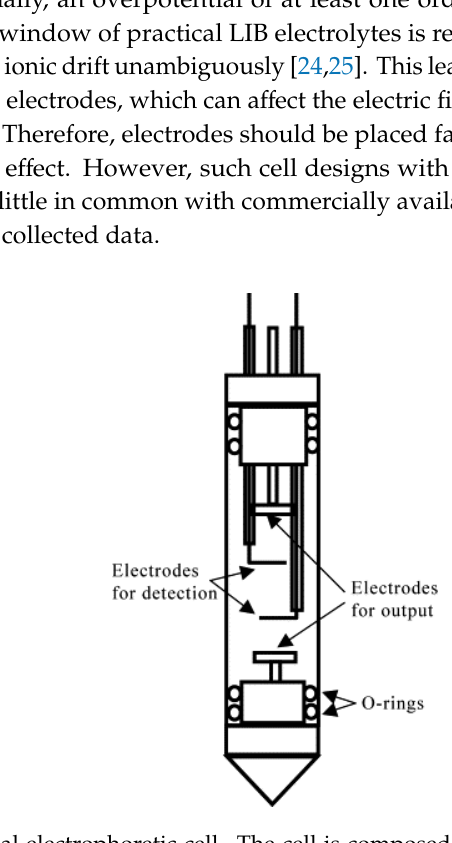
Figure 2. Four-terminal electrophoretic cell. The cell is composed of a cylindrical glass tube with a diameter of 10 mm. The distance between the output electrodes is 3.2 cm and that between the detection electrodes is 2.0 cm. Teflon rings are used to prevent any solution leakage. (Reproduced with permission from [21]; Copyright 2002 Elsevier).